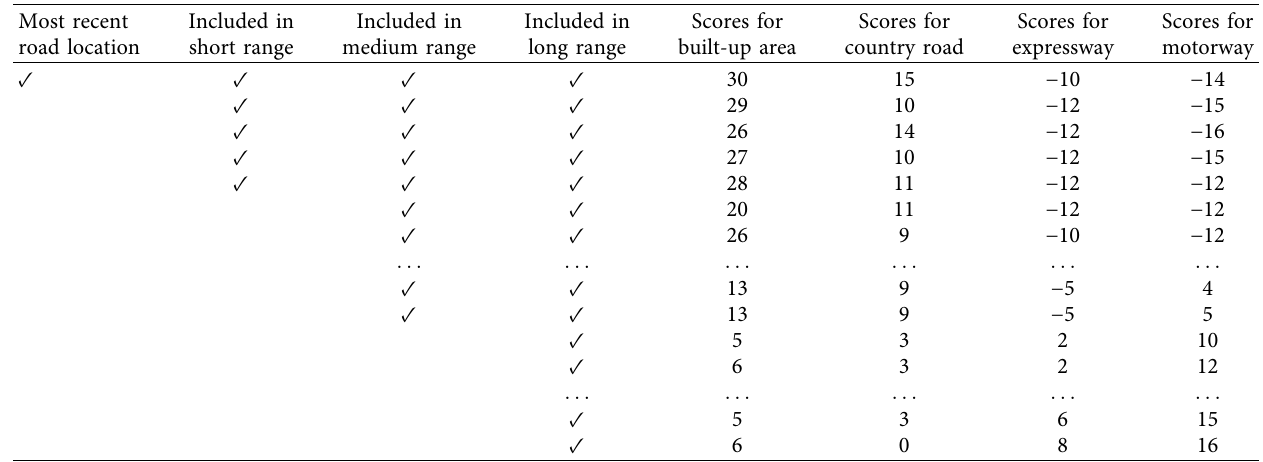
Table 5: The score queues for the considered road types.